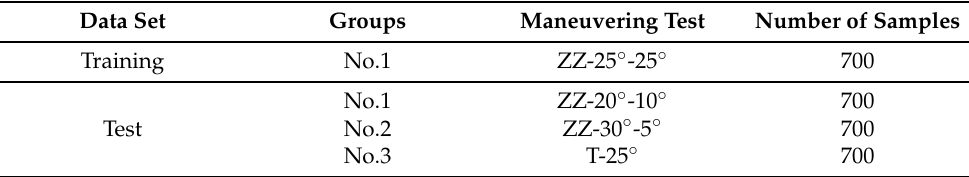
Table 1. Training and simulation experiment settings.